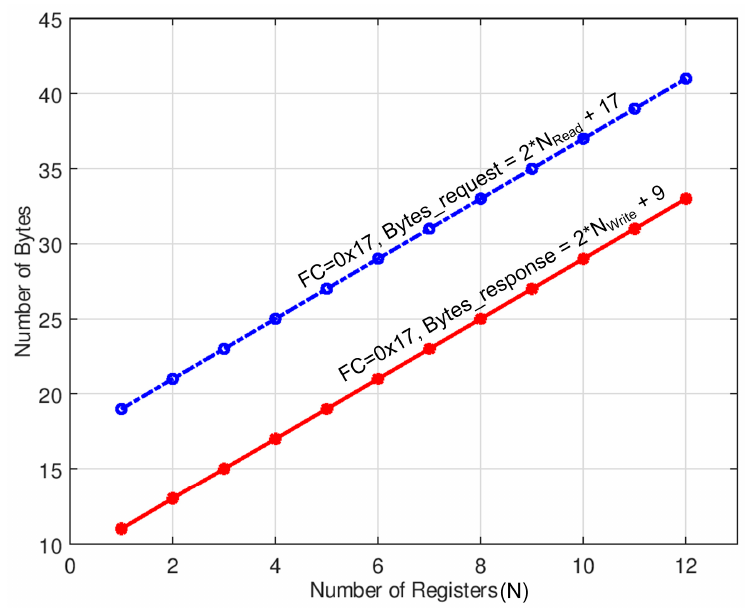
Figure 3. Relationship between the number of bytes and the number of registers of the MODBUS function code (FC) “read/write multiple registers” (0x17).